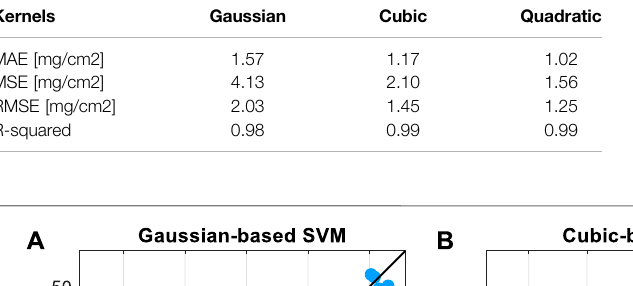
TABLE 2 | Performance indicators for mass loading prediction using different kernel-based SVMs. Kernels